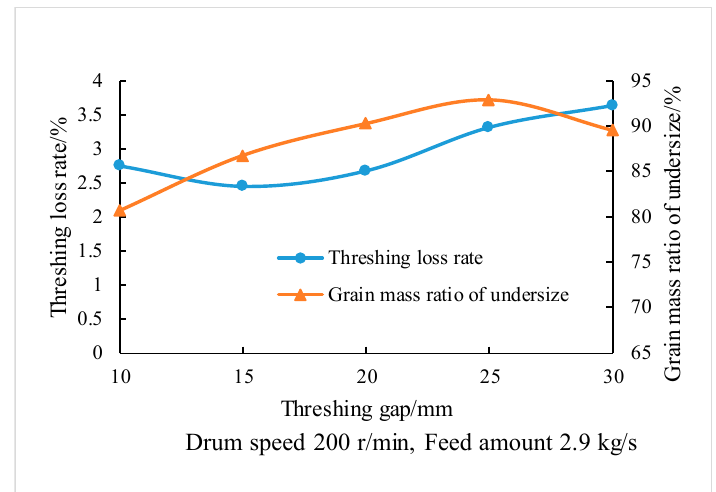
Figure 8. Effect of disengagement gap on threshing performance.